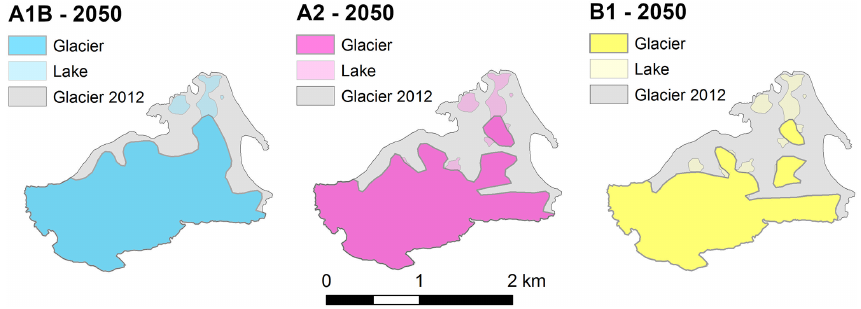
Figure 7. Modelled future glacier extent and potential areas for lake formation for 2050 under Scenario A1B, Scenario A2, and Scenario B1.